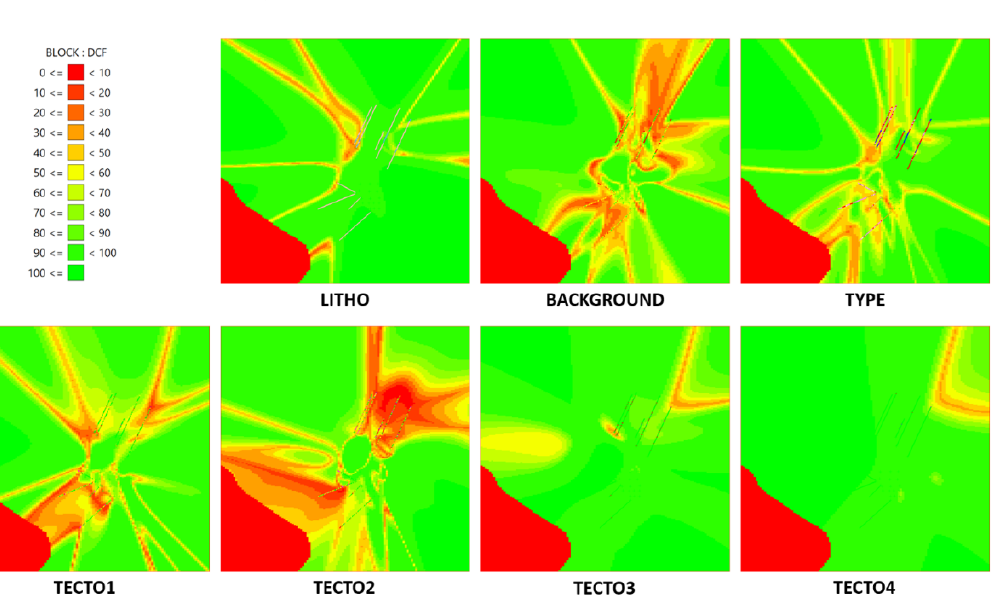
Figure 5. DomainMCF prediction confidence levels.